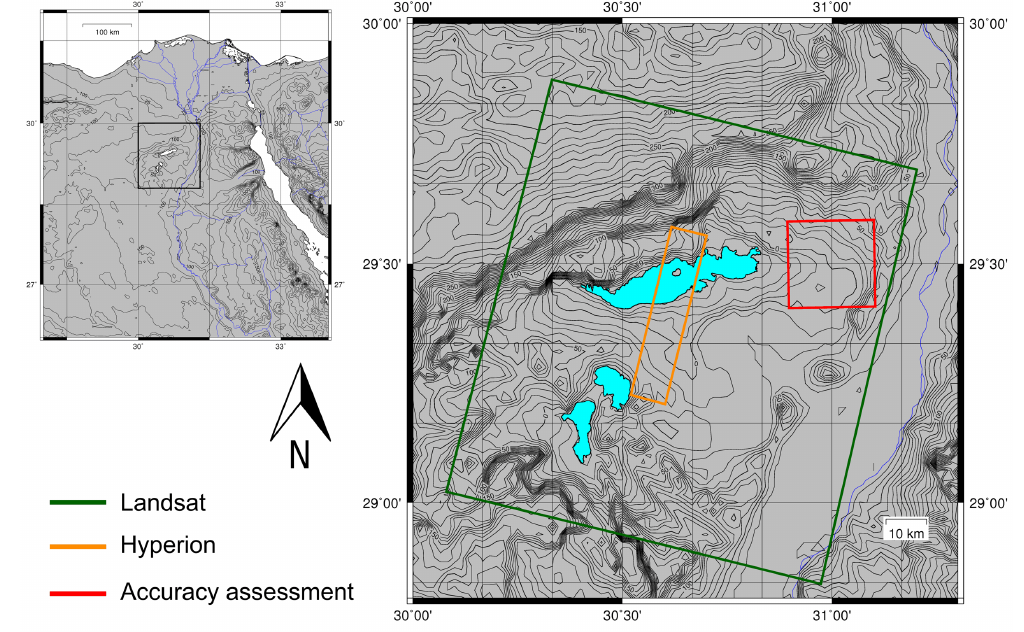
Figure 1. Location of the study area and data coverage.